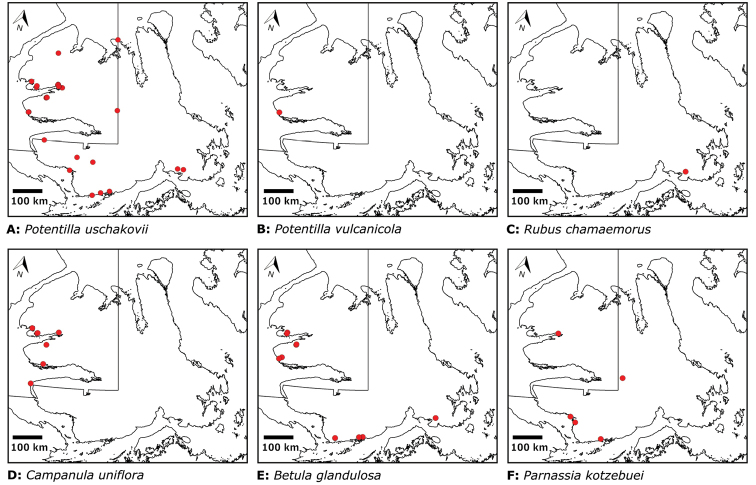
Species distribution maps. Rosaceae: APotentilla
uschakoviiBPotentilla
vulcanicolaCRubus
chamaemorus. Campanulaceae: DCampanula
uniflora. Betulaceae: EBetula
glandulosa. Celastraceae: FParnassia
kotzebuei.